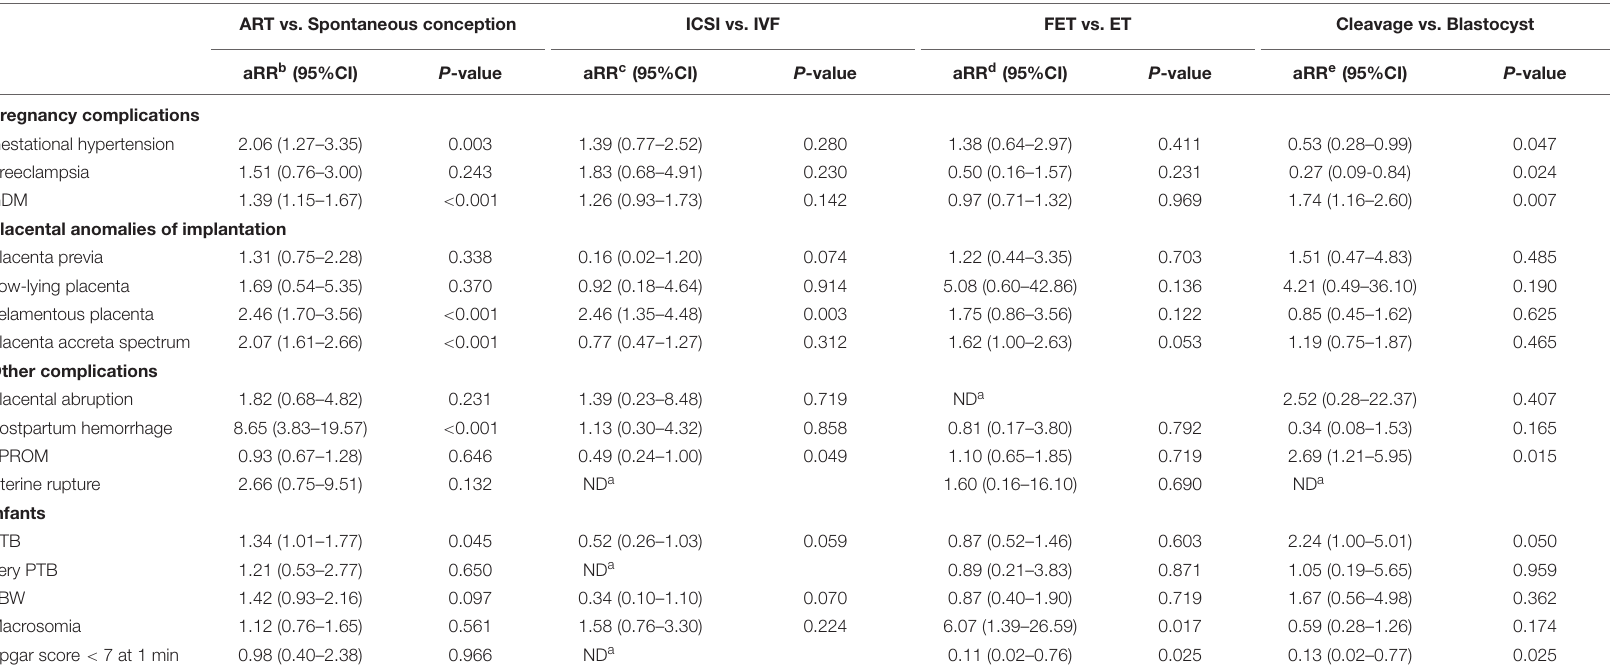
TABLE 5 | The effect of ART procedures on obstetric and perinatal outcomes of singletons in women with previous